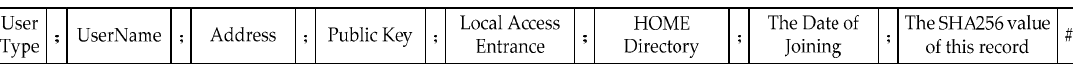
Figure 2. The schematic diagram of the storage structure of User Files.